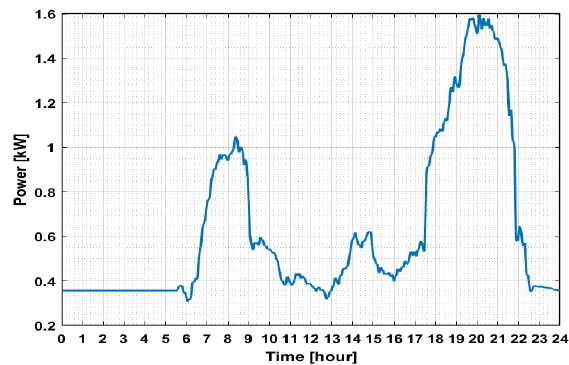
Figure 4. Aggregated non-eCook load for 108 HHs.